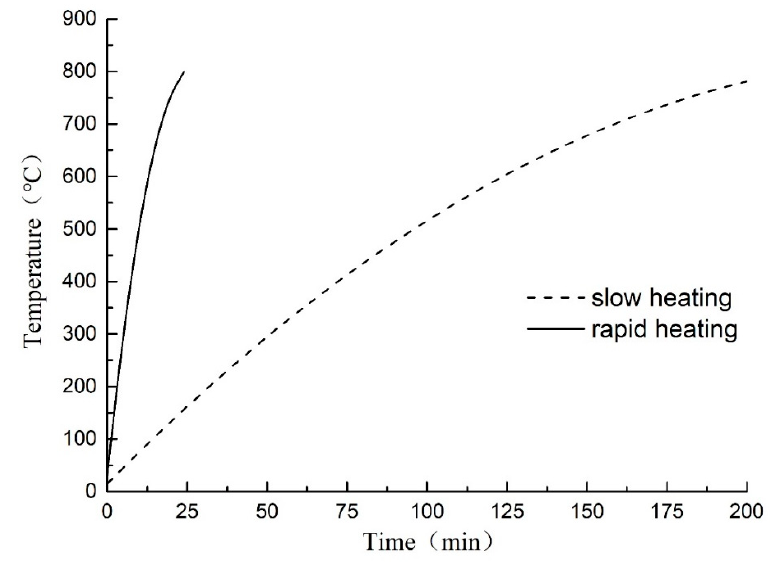
Figure 1. Heating gradient curves.